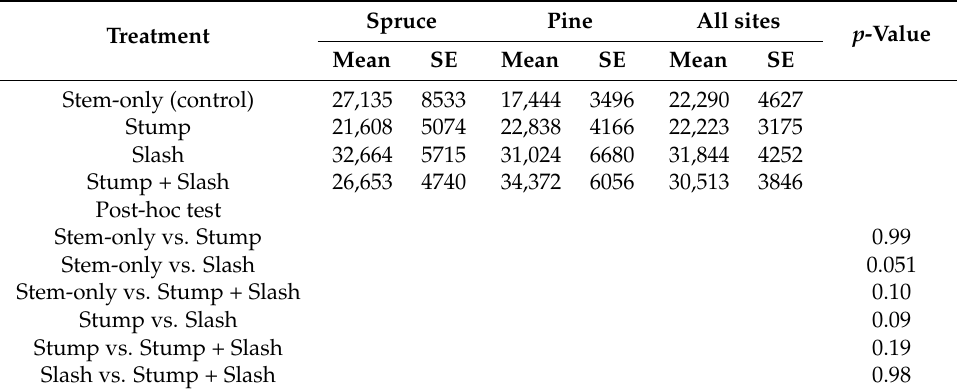
Table 5. Sum of naturally regenerated seedlings (ha − 1 ) five years after additional harvest of stumps, slash, both stumps and slash, relative to the control treatment where only the stem wood was harvested leaving stumps and slash